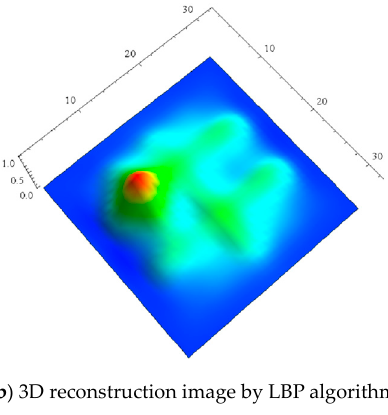
Figure 6. Sample 2 of defect.